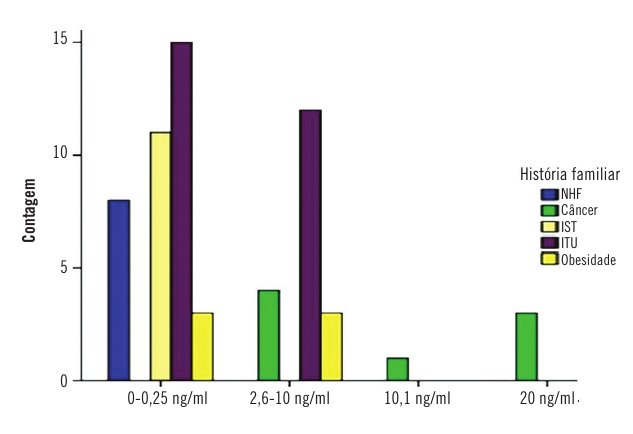
FIGuRA 4 – Histograma da distribuição dos níveis de concentração do PSA de acordo com a história patológica da família PSA: antígeno prostático específico; IST: infecções sexualmente transmissíveis; ITU: infecções do trato